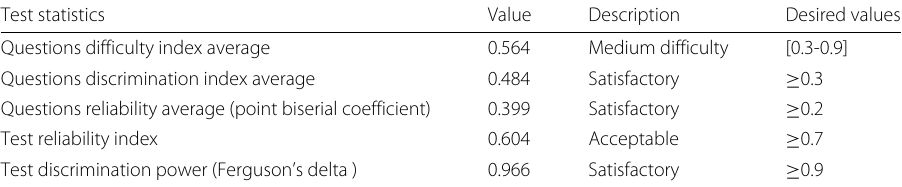
Table 18 Test-three analysis (number of students attempts = 89)